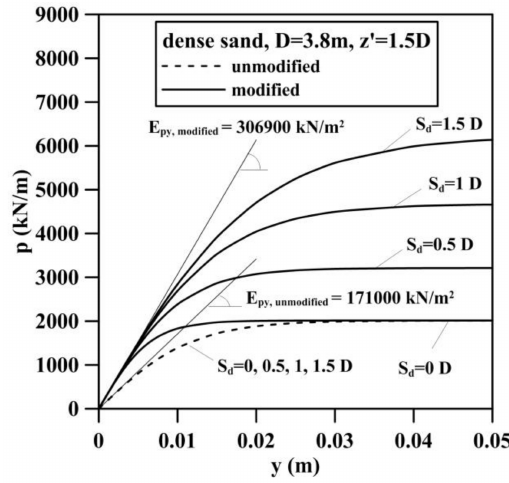
Figure 12. p – y curves for various scour depths at depth of 1.5 D below the bottom of the scour hole. (cid:16) E py , modified / E py , unmodified = 1.8